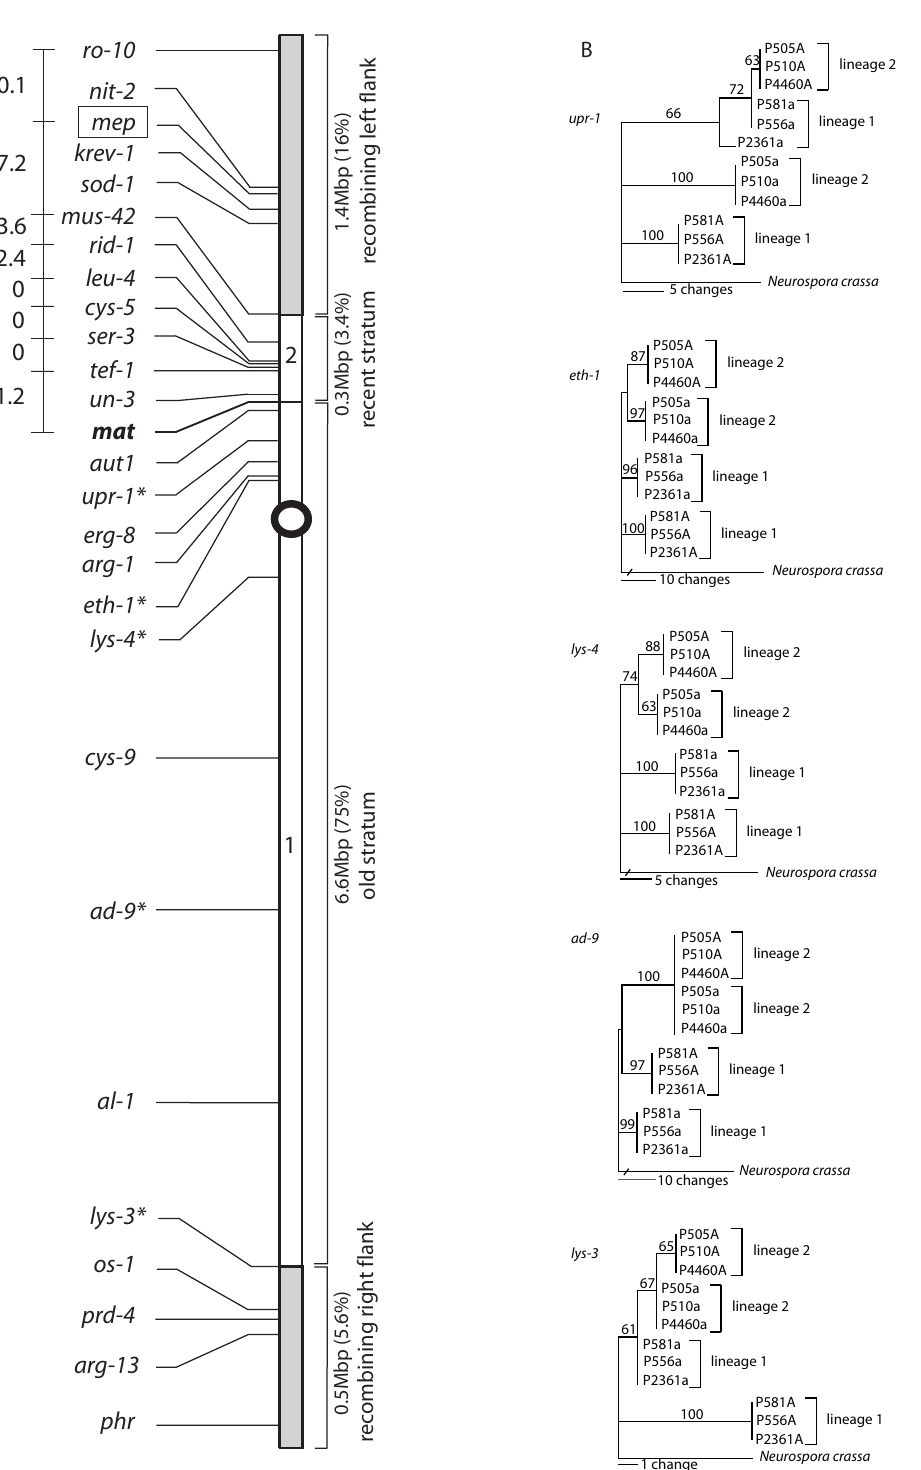
Figure 1. Genetic Map of the N.tetrasperma Mating-Type Chromosome Showing Markers used in this Study. A. Left arm of the chromosome is positioned towards the top. Gene order as assumed from the N. tetrasperma mat a- chromosome of single mating-type component P581a (2509). Markers with asterisks (*) were also used in the genealogy study; mep (boxed) was only used as a phenotype marker in crosses. The two d S -defined evolutionary strata of strain P581 along the chromosome are indicated and numbered. Numbers to the left of markers ro-10 – mat indicate crossover-frequencies when the mat a -chromosome of the mat a -component strain of P581 was introgressed into N. crassa background and crossed with a N. crassa mat A strain. B. One most parsimonious tree of each of the five selected genes of the old stratum. The 12 strains used are single mating-type components of six wild-type N. tetrasperma heterokaryons belonging to two different phylogenetic lineages [20]. For clarity, each strain is referred to by the original heterokaryon number followed by the appropriate mating type ( mat A or mat a ; Table 1). Bars indicate number of changes, and numbers by branches indicate bootstrap values of above 50% (1000 replicates).